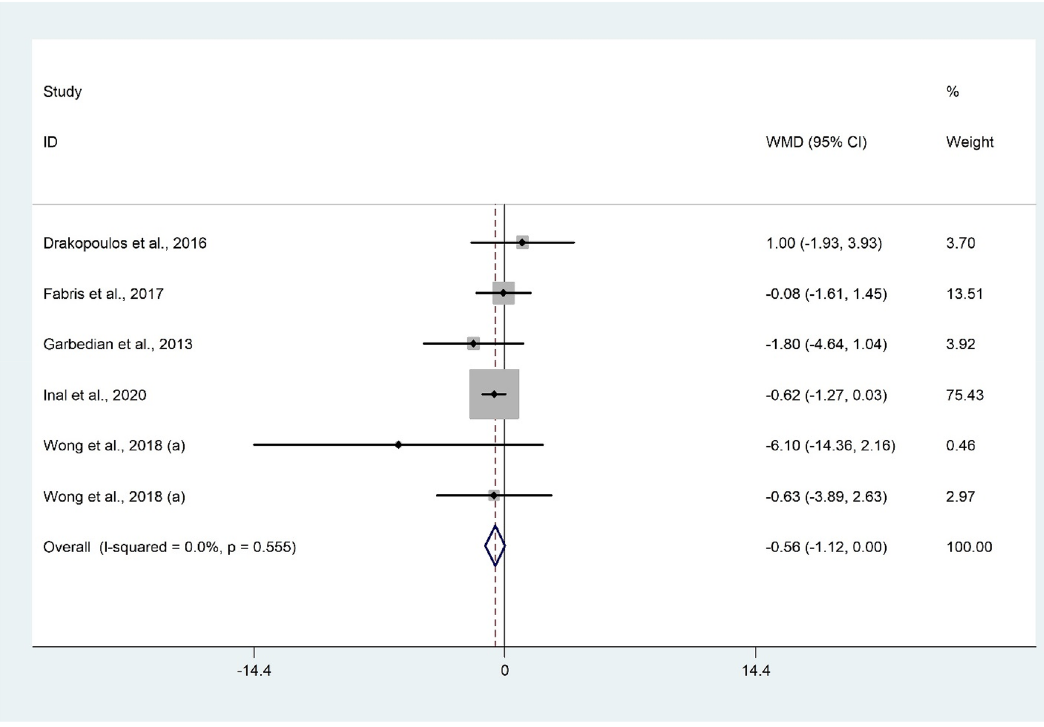
Figure 2. Forrest plot of the comparison of the AFC between women with vitamin D insufficiency/deficiency and sufficient